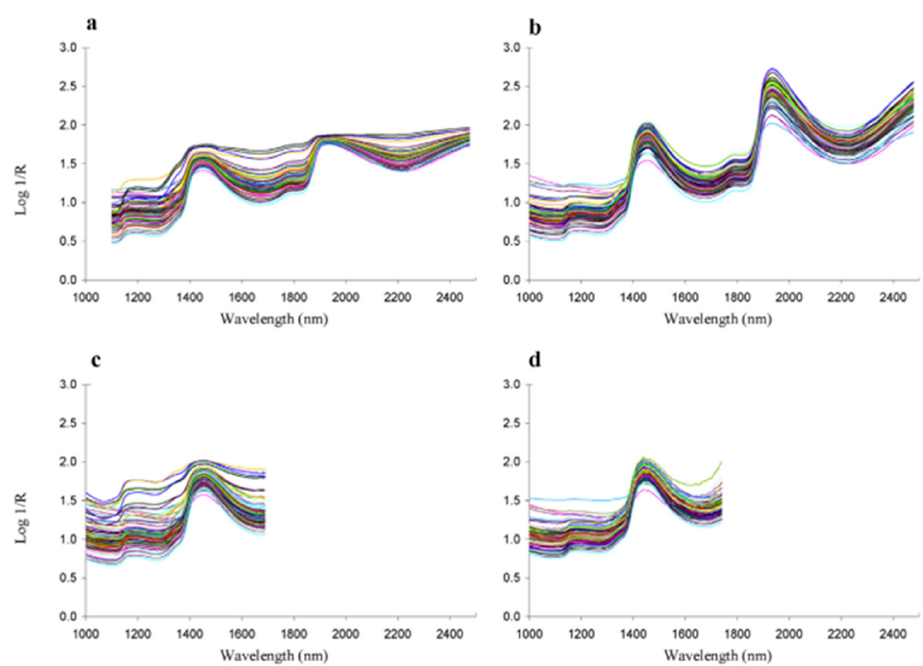
Figure 3. Reflectance spectra of scanned samples with four different NIR spectrometers: ( a ) Dispersive benchtop instrument (NIRSystem 5000); ( b ) FT-NIR benchtop instrument (NIRFlex N-500); ( c ) Diode array portable instrument (Corona 45); ( d ) MEMS portable instrument (LAB POD™) reproduced from [71], with permission from ELSEVIER, 2021.